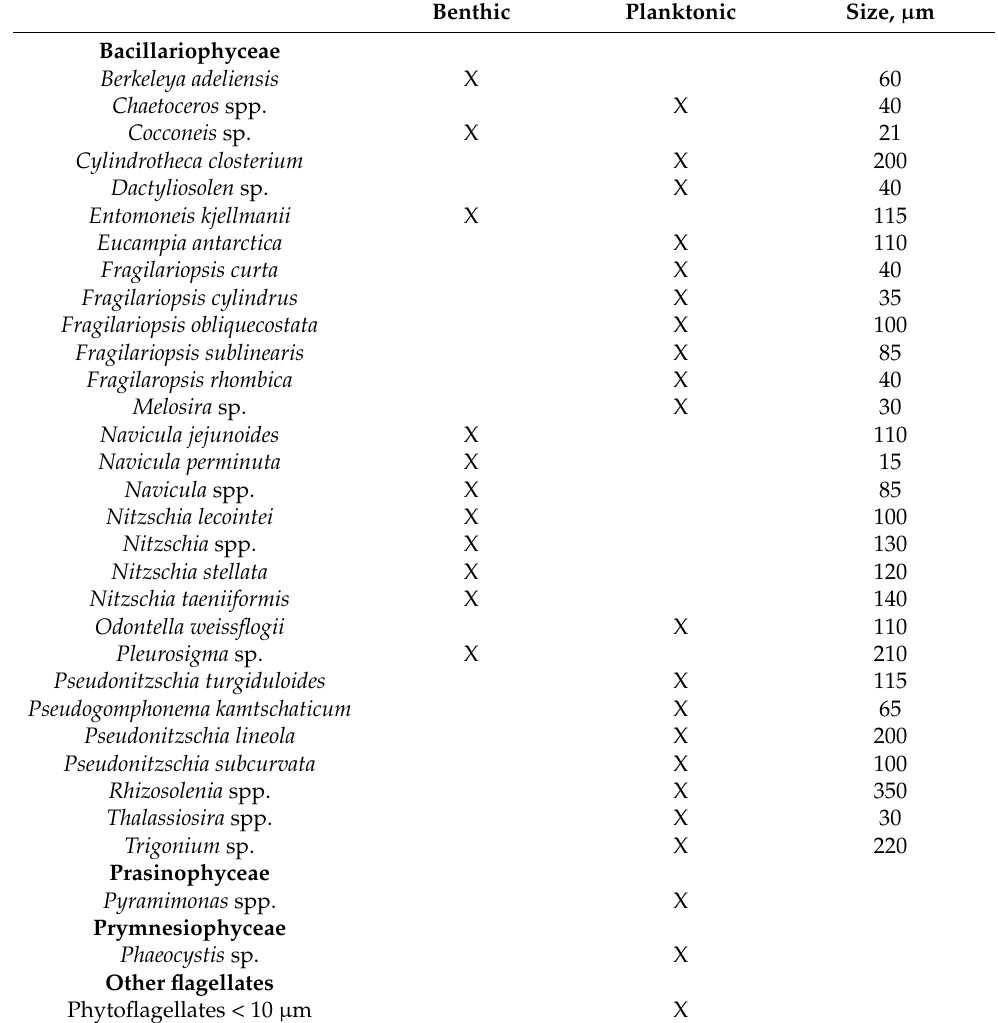
Table 1. Phytoplankton species sampled at PIPEX station. Size and key habitat are